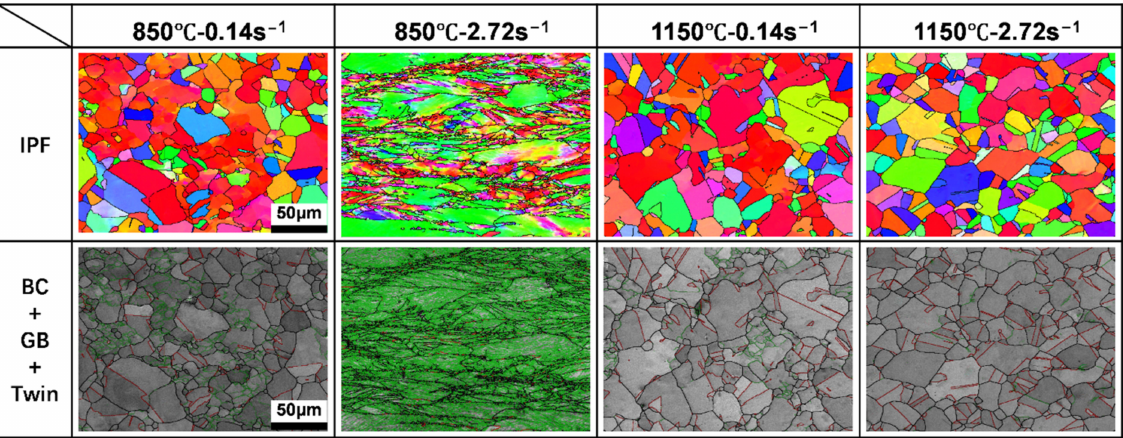
Figure 10. T EBSD maps of IPF, HAB and LAB, Twin deformed at 850 ◦ C and 0.14 s − 1 , 850 ◦ C and 0.17 s − 1 , 1150 ◦ C and 0.14 s − 1 , 1150 ◦ C and 0.14 s − 1 ,